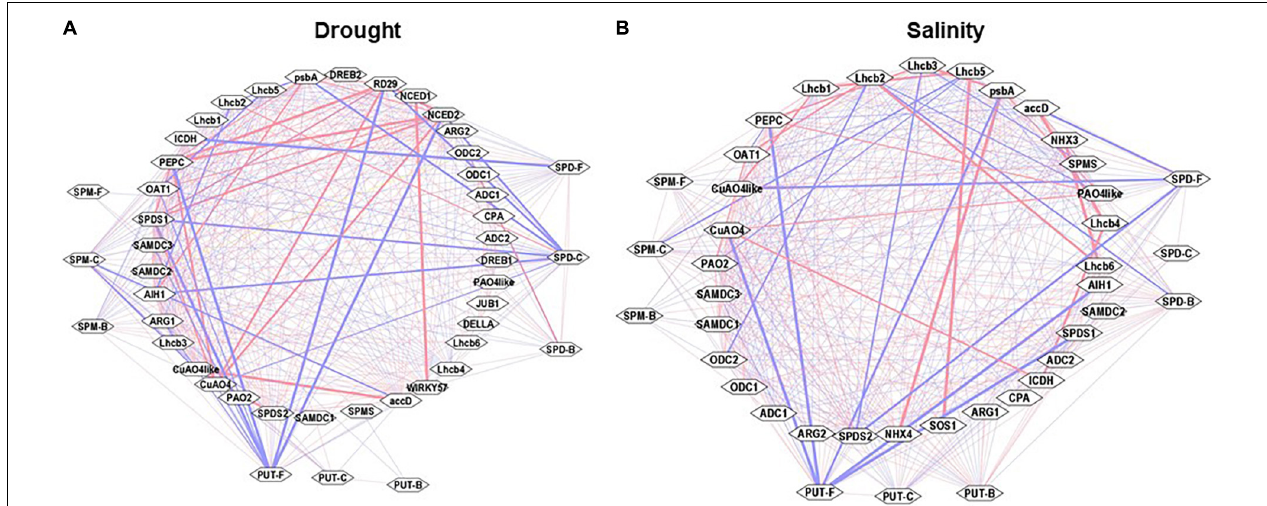
FIGURE 10 | Cytoscape analyses (interactive networks) of different PAs form with the transcript abundances of genes analyzed during drought and salinity stress. Positive (red) and negative (blue) correlations of cellular levels of PUT-F, SPD-F, SPM-F, PUT-C, SPD-C, SPM-C, PUT-B, SPD-B, and SPM-B, and transcript abundance of PAs biosynthesis and catabolizing enzymes genes are shown. Also included in the Cytoscape analysis are the Pearson correlations of selected drought (A) and salinity (B) stress maker genes and photosynthesis processes and carbon fixation pathway genes. Other details are given in the section “Materials and